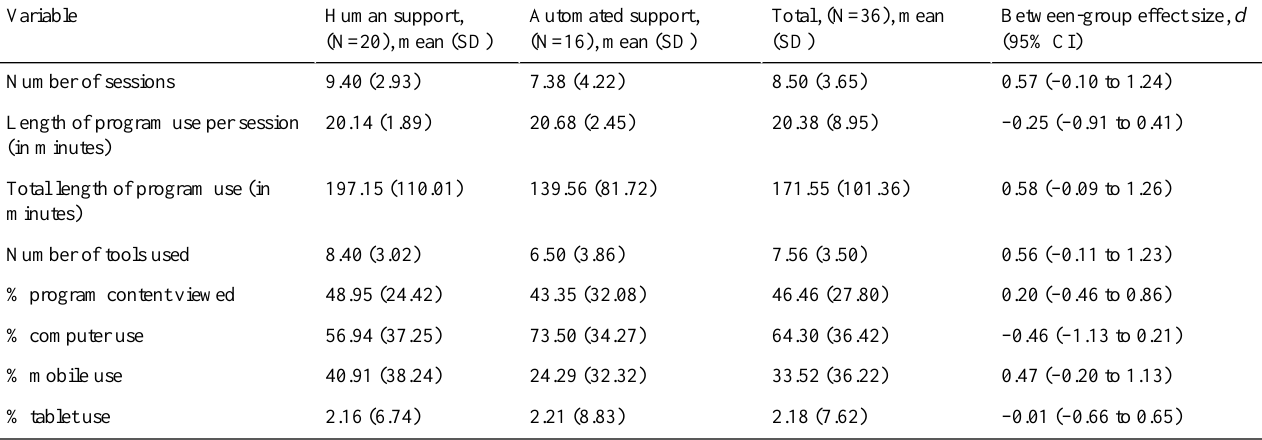
Table 4. Descriptive statistics for program engagement and usage.